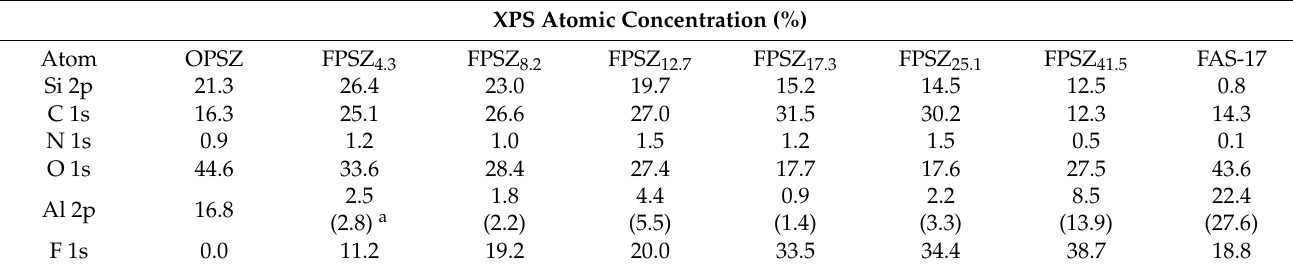
Table 2. Elemental compositions of the OPSZ-, FAS-17- and FPSZ-coated rough Al substrates.